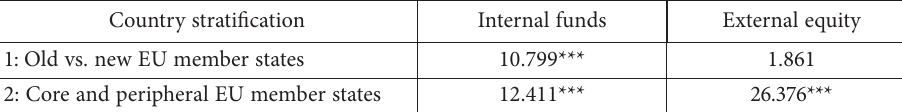
Table 3. The results of Kruskal-Wallis test for the relevance of sources of equity financing and the dimension of countries stratification